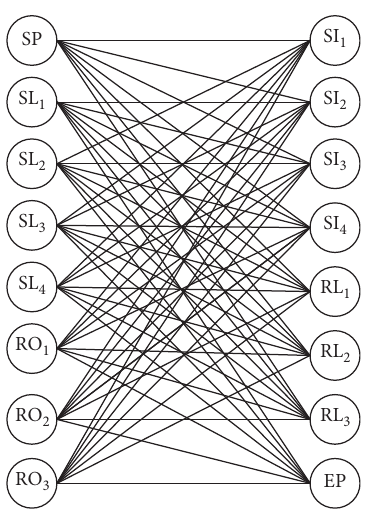
Figure 9: Bipartite graph of four storage requests and three re- trieval requests.